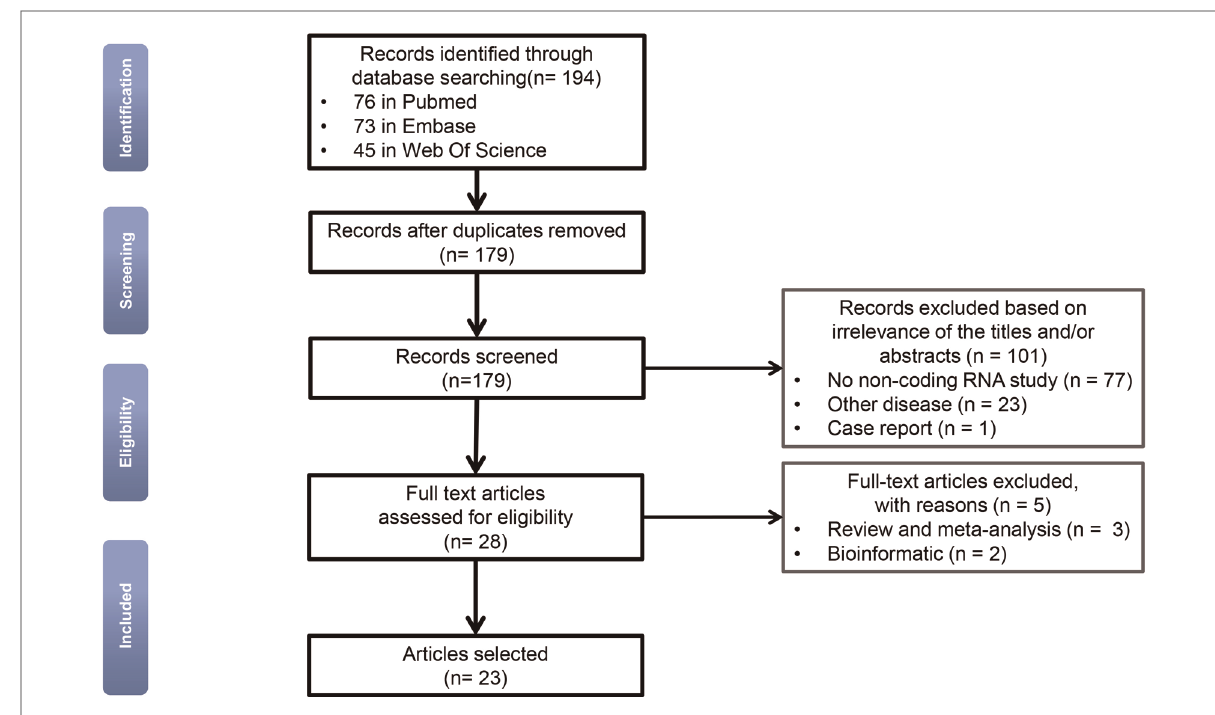
Figure 1 Flow-chart diagram for selection of relevant studies (n = number of